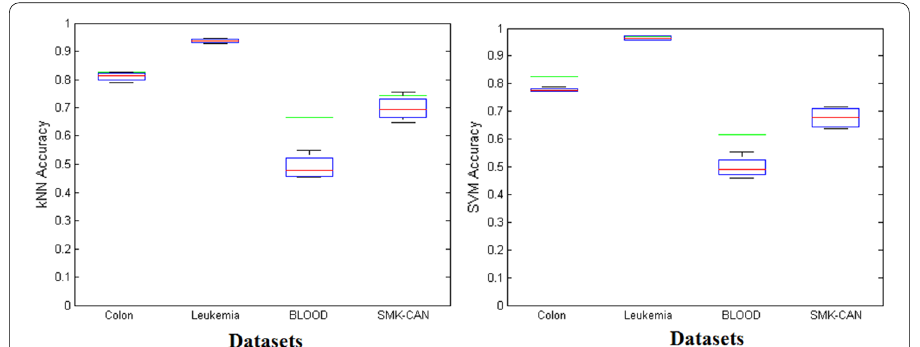
Fig. 11 Accuracy evaluation of ReliefF using KNN and SVM. Green line represents Bagging while Black Lines, Red line and Blue box represent maximum, minimum, median and quartile of baseline performance respectively